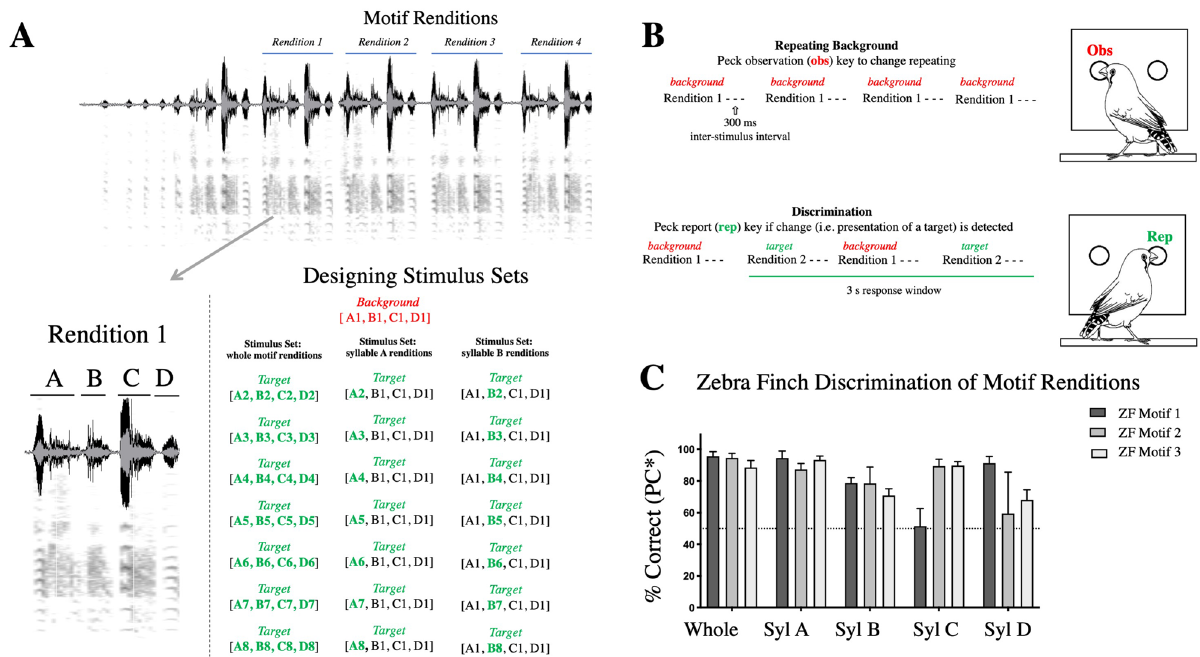
Figure 1. ( A ) Time waveform (top) and spectrogram (bottom) for a natural zebra finch song bout (made in Sonic Visualiser 51 ). The blue lines denote distinct motif renditions, composed of the same four syllables (indicated as discrete notes via the time waveform). The panel below indicates how individual syllables were identified within a single motif rendition. A single motif (e.g. rendition 1) was used as a repeating background (ABCD, with fixed inter-syllable silences) and targets (sounds different from the background that birds were tasked with discriminating) consisted of different renditions of all syllables or one of the syllables. The right panel shows exemplar stimulus sets used to test discrimination ability among renditions of motifs and syllables. Birds were tested on five stimulus sets per male’s motif (three of which are shown), for each of three males. For the whole motif rendition set, the background was composed of each syllable from one motif rendition and each of the seven targets were comprised of each syllable from a different rendition ( stimulus set: whole motif renditions ). For the other four stimulus sets, the background was again composed of each syllable from a motif rendition, and each target contained a different rendition of a single syllable and the same rendition as the background for the other syllables ( stimulus set: syllable A renditions and syllable B renditions ). Target syllables differing from the background are green and bolded. ( B ) Schematic of the behavioral operant task. While listening to a repeating background sound, a bird can initiate a trial by pressing the observation key. After a 2–7 s random interval, another peck to the observation key resulted in the presentation of a target sound (a different rendition) alternated with the background sound. Each target is presented twice within a 3 s response window during which a peck on the report key is scored as a hit. ( C ) Average performance (corrected percent correct (PC*) for discriminating target stimuli, mean ± SEM, N = 4) on discrimination of motif and syllable renditions from three male zebra finch motifs (ZF Motif 1–3). The authors thank Shelby Lawson for the drawing of the zebra finch in ( B